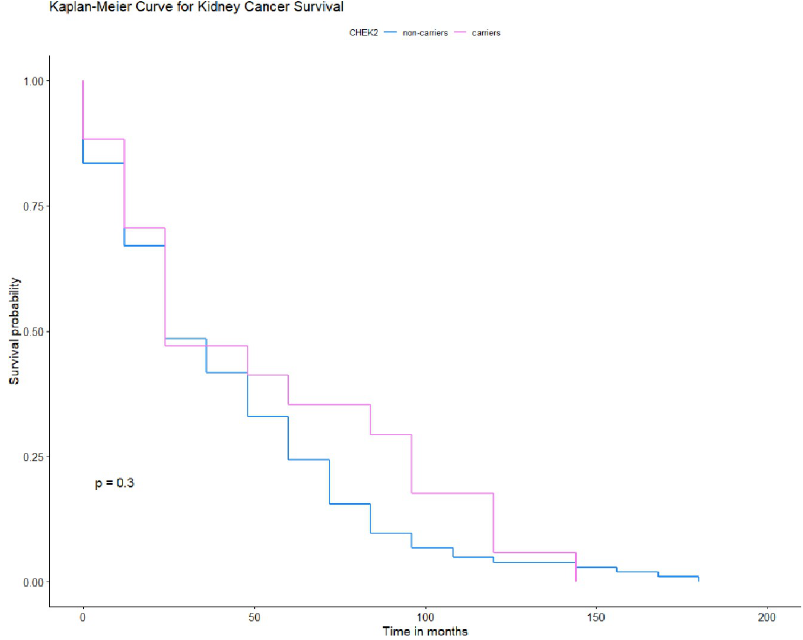
Fig 3. Kaplan-Meier survival curves of kidney cancer patients with any CHEK2 mutation and -negative sub- cohorts.